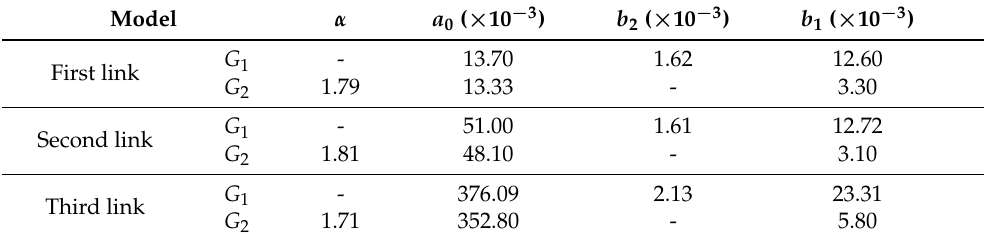
Table 2. Model parameters obtained from identification procedure.